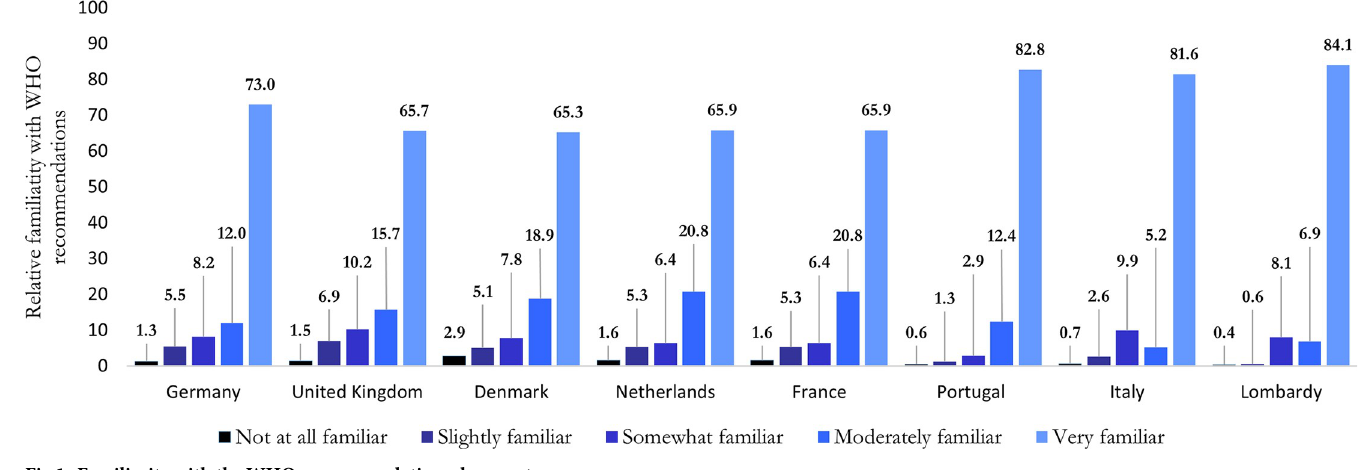
Fig 1. Familiarity with the WHO recommendations, by